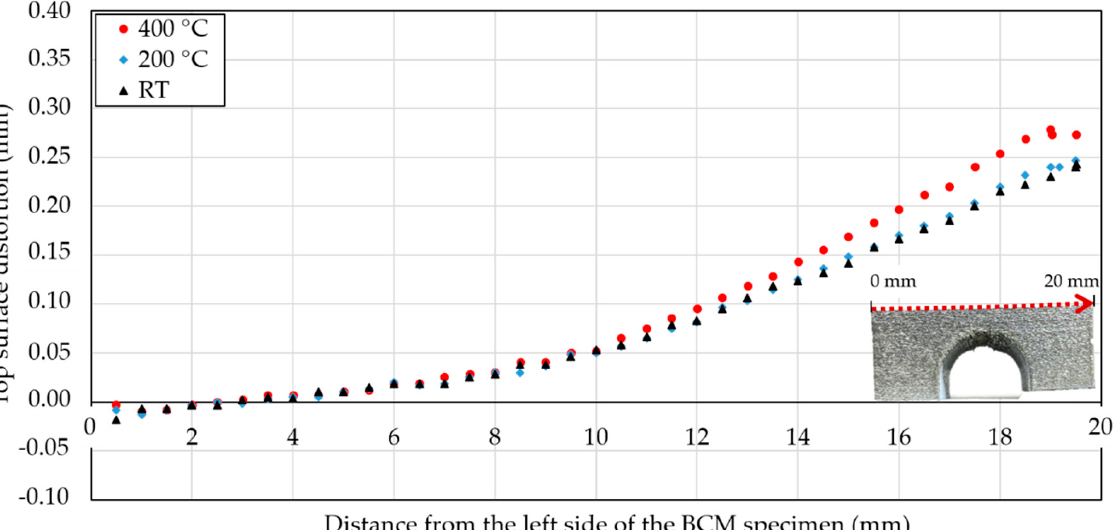
Figure 3. The mean values of 0° and 90° top surface deflection of BCM specimens according to base plate preheating temperature.